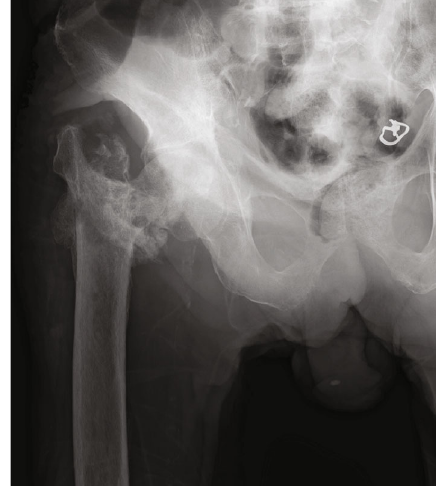
Figure 6: A radiograph at 1 year after implant removal showing nonunion of the right trochanter of the